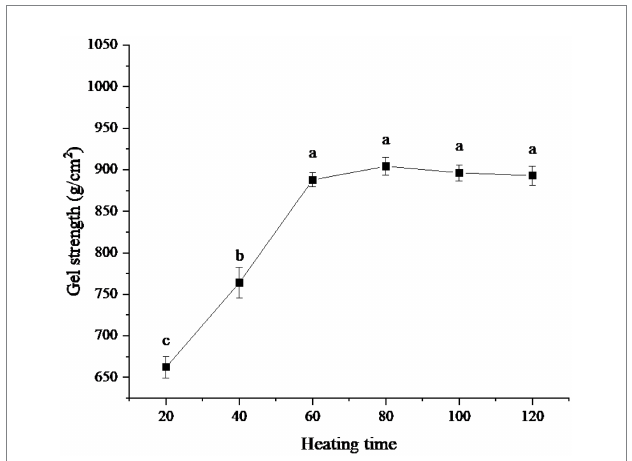
FIGURE 4 Effect of heating time on gel strength of protein powder. Different lowercase letters express the significant differences ( p < 0.05).